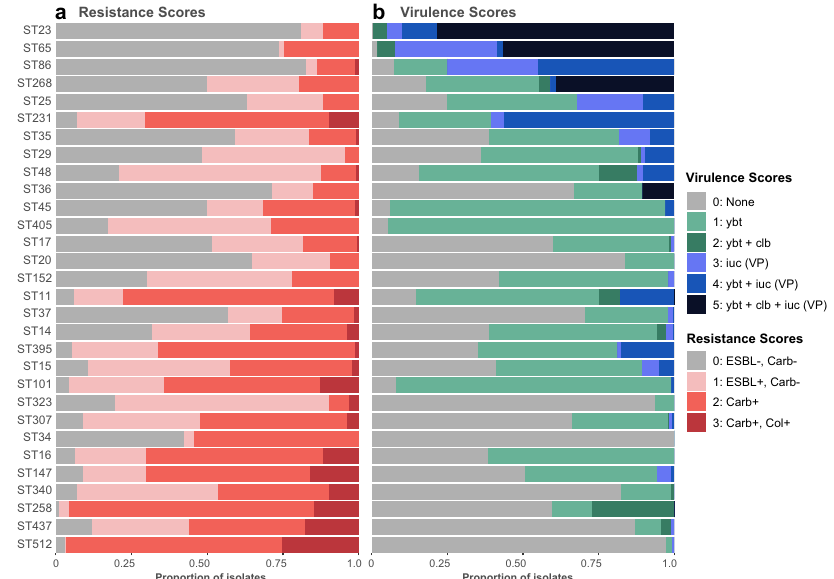
Fig. 5 Distribution of (a) resistance and (b) virulence scores among genomes belonging to the 30 most common K. pneumoniae lineages. Data shown summarize Kleborate results for non-redundant set of 9705 publicly available K. pneumoniae genomes (Supplementary Data 2). Lineages were de fi ned on the basis of multi-locus sequence types (STs) reported by Kleborate, and ordered from highest to lowest difference between mean virulence and mean resistance score. Minimum genome count per ST shown is 50. Ybt yersiniabactin, clb colibactin, iuc aerobactin, VP virulence plasmid, ESBL extended- spectrum β -lactamase, Carb carbapenemase, Col colistin resistance